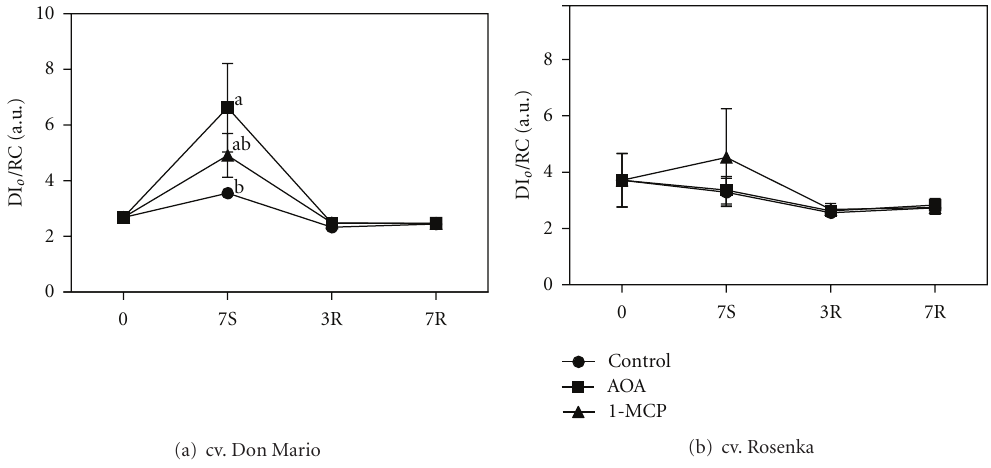
Figure 6: Dissipation energy per active reaction center (DI o /RC) measured from leaves of cv. Don Mario (a) and cv. Rosenka (b) stored for 7 days (7S) at 14 ◦ C and transferred at 20 ◦ C for recovery evaluation (3R and 7R). Values are means with standard errors ( n = 10). Data were subjected to one-way ANOVA and di ff erent letter, when present, mean that values are statistically di ff erent P < 0 .